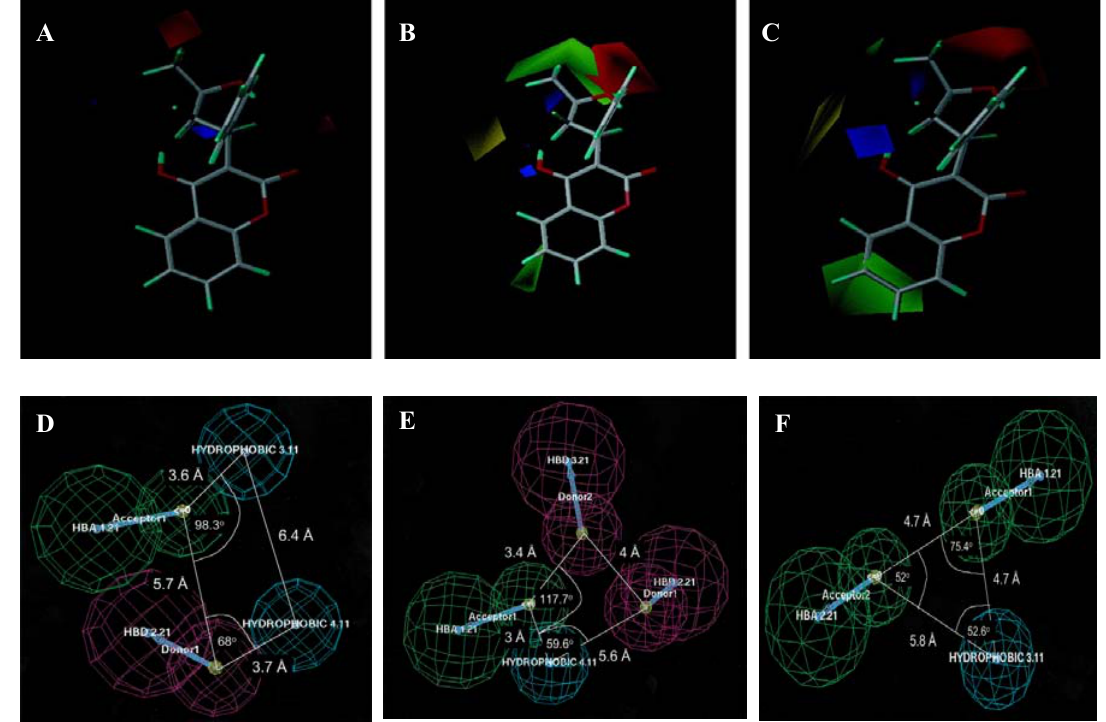
Figure 5. ( A ), ( B ) and ( C ): electrostatic and steric interactions in the original CYP2C9 CoMFA model, model 2C9 with 27 inhibitors and model 2C9 with 41 inhibitors. Red and blue indicate where more negative and positive charge will enhance binding. Yellow areas indicate where steric interactions hinder binding. Green areas depict where steric interactions enhance binding. Figures were adapted from references [54,55]. ( D ), ( E ) and ( F ) Catalyst three dimensional pharmacophore models 1, 2 and 3 with features illustrating hydrophobic areas (cyan), hydrogen bond donor (HBD, purple), and a hydrogen bond acceptor feature (HBA, green) with a vector in the direction of the putative hydrogen bond donor. These figures were adapted from reference